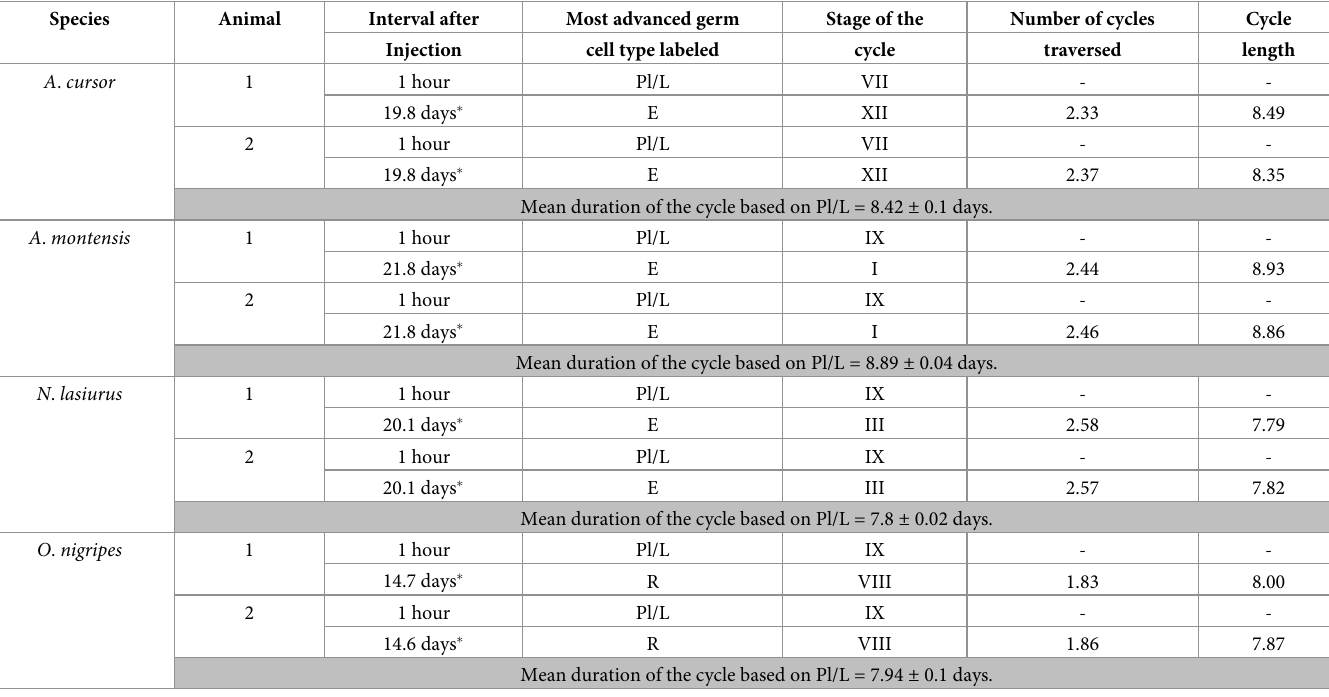
Mean duration of the cycle based on Pl/L = 7.94 ± 0.1